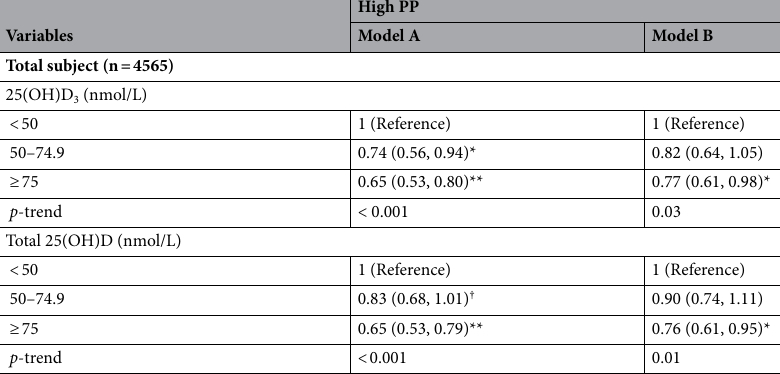
Table 3. Adjusted multiple logistic regression and 95% CIs of high pulse pressure by vitamin D concentrations in all subjects aged ≥ 50 years. Model A was adjusted for age, sex, and race/ethnicity. Model B: Model A + further adjusted for education, season of examination, physical activity, alcohol consumption, smoking status, dietary covariates (intakes of total energy, potassium, calcium, magnesium, and sodium), height, weight, and diabetes. ** p < 0.001, * p < 0.05, † p < 0.1 compared with vitamin D levels < 50